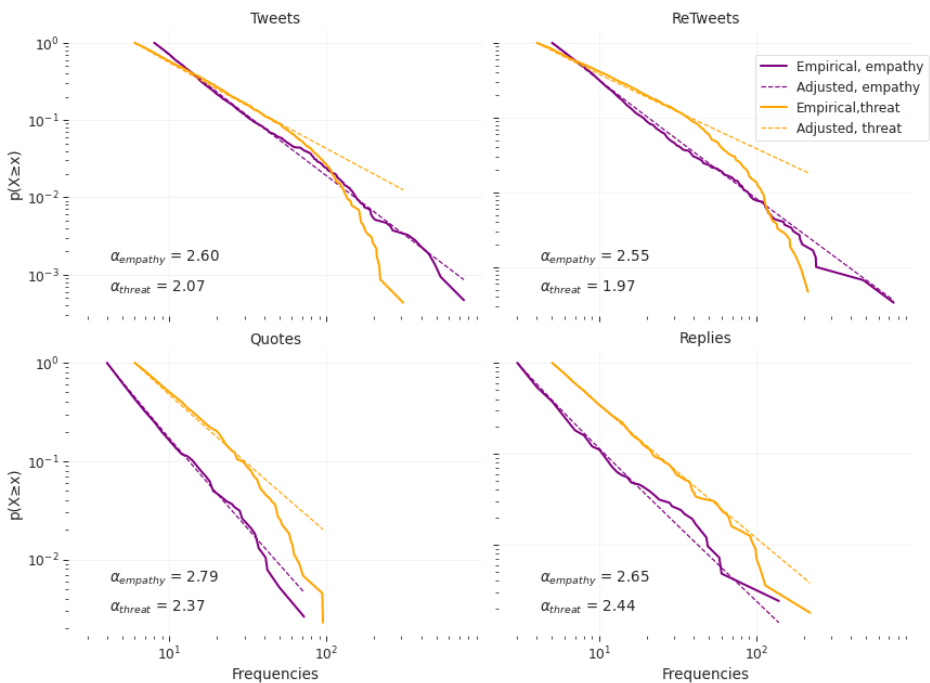
Figure 6. Powerlaw distributions for content